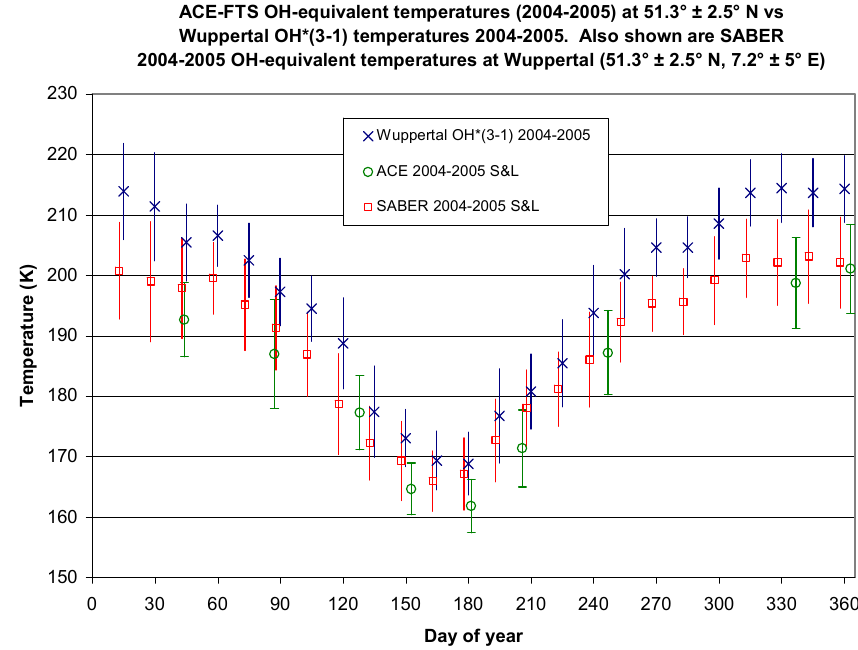
Fig. 12. ACE-FTS OH-equivalent temperatures for a 5 degree latitude band centred on Wuppertal compared with the OH*(3-1) 30-day moving average rotational temperature (at 15-day intervals) recorded at Wuppertal in 2004 and 2005. Also shown in this figure are 30- day averaged OH-equivalent temperatures for 2004 and 2005 from the SABER instrument (calculated in the same way as the ACE-FTS temperatures) on the TIMED satellite at 51.3 ◦ ± 2.5 ◦ N, 7.2 ◦ ± 5 ◦ E. The SABER points have been offset by − 2 days on the x-axis to improve the clarity of the figure. The error bars are one standard deviation in all